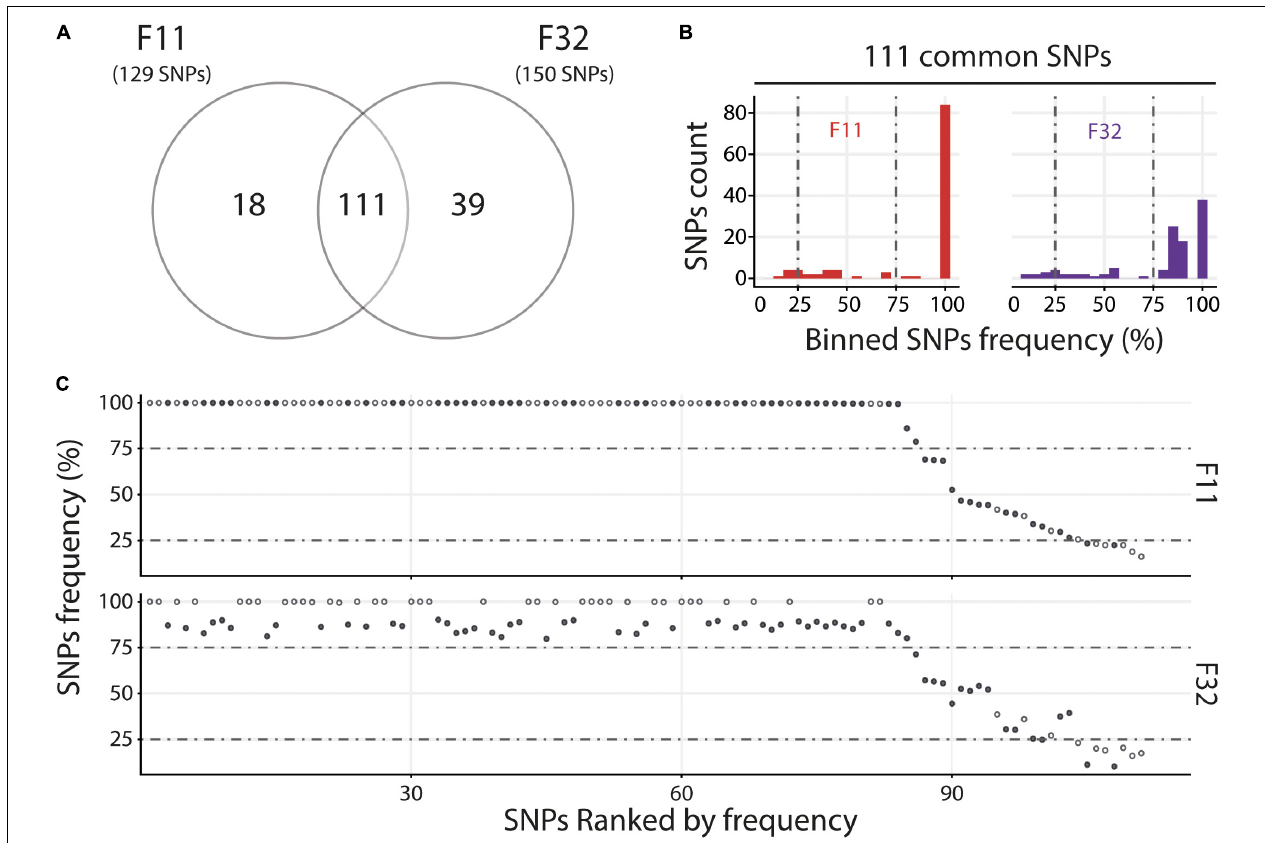
FIGURE 6 | Distinct heterogeneous viral populations infect oyster families during Mediterranean experimental infection. (A) Venn diagram representation of the number of specific and common SNPs in viral populations infecting each susceptible oyster families (F11/32). (B) The frequency distribution of common SNPs across the 2 infected families is illustrated by a histogram. SNPs are binned at 5% intervals along the x -axis, and the number of SNPs in each bin is indicated on the y -axis. (C) Common SNPs are ordered according to decreasing variant frequency in F11 family and plotted for the same position in F32 family. Black and white dots correspond to SNPs with different or similar variant frequencies (difference < 5%),